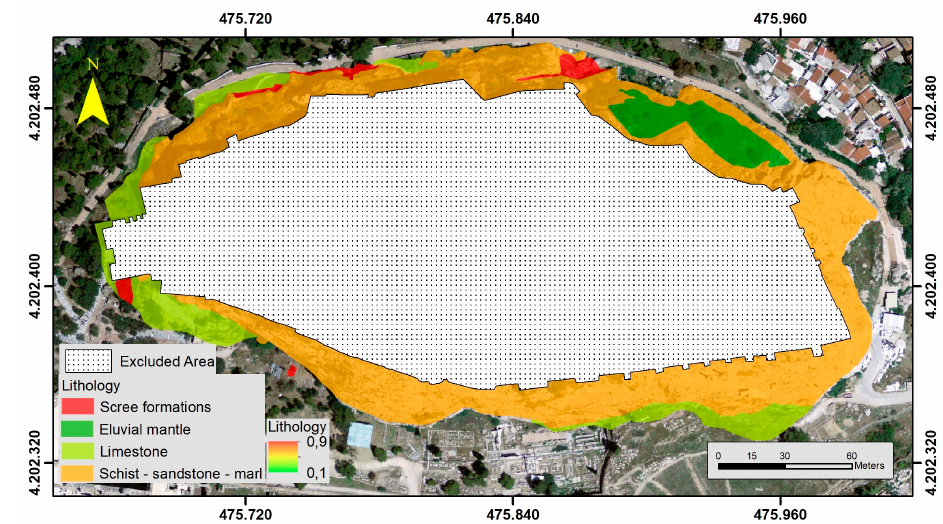
Figure 4. Instability related parameters (normalized): Lithology.